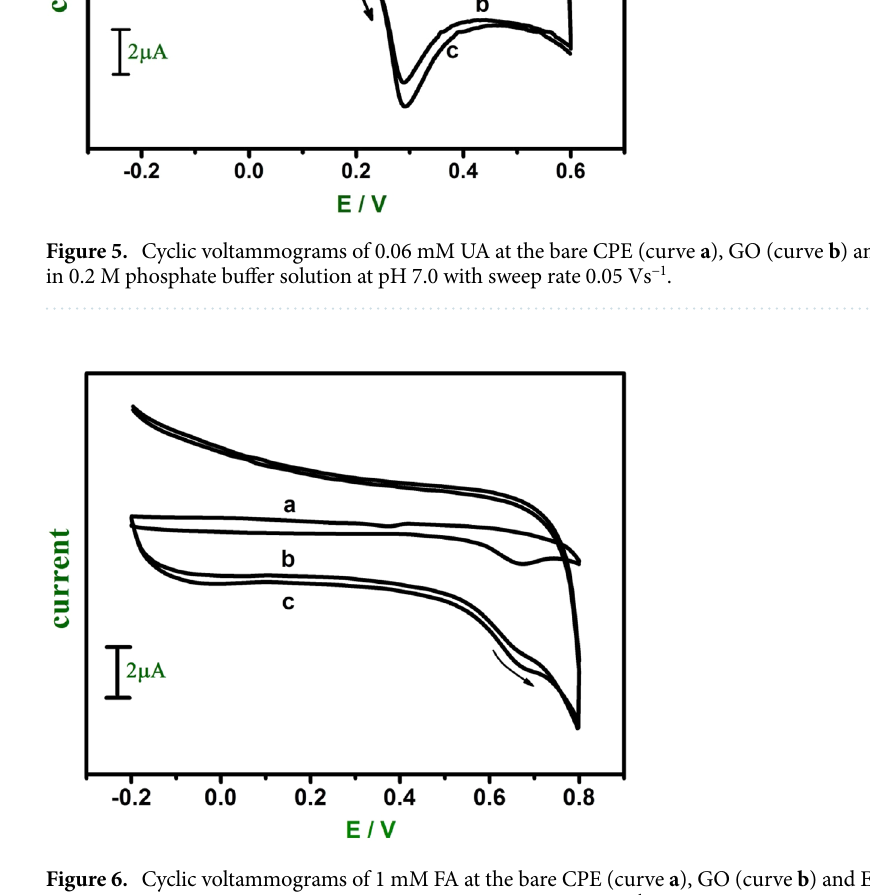
Figure 6. Cyclic voltammograms of 1 mM FA at the bare CPE (curve a ), GO (curve b ) and E-GO (curve c ) in 0.2 M phosphate buffer solution at pH 7.0 with sweep rate 0.05 Vs −1